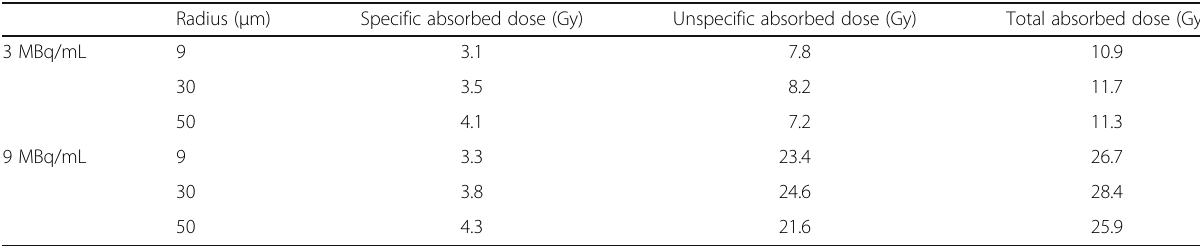
Table 2 Absorbed dose to